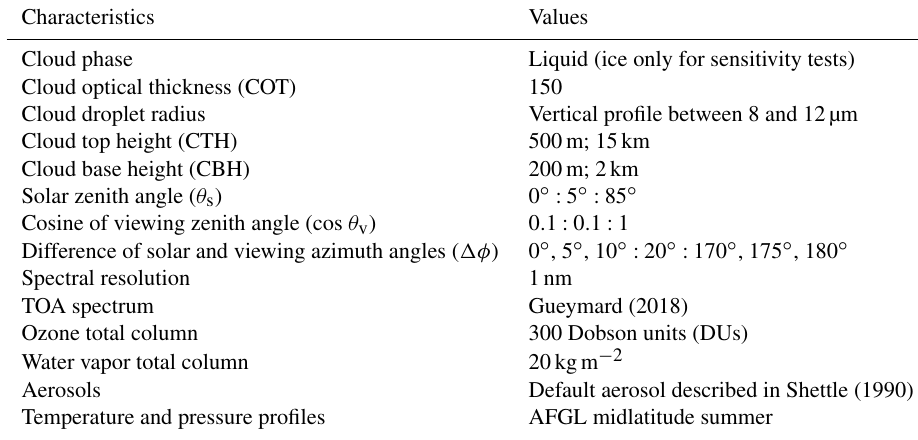
Table 1. Characteristics of the look-up table of cloudy TOA reflectances.